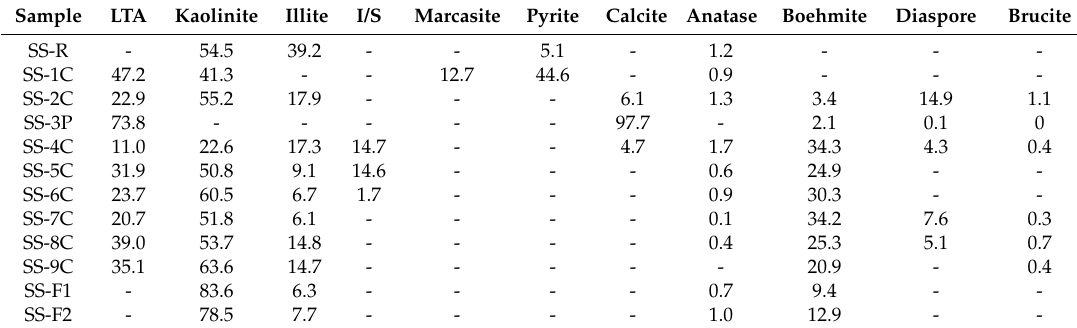
Table 4. Low temperature ash (LTA) yields of coal samples and mineral compositions (%) of LTAs, parting, roof and floor determined by XRD and Siroquant. “-“means below the detection limit of Siroquant analysis.